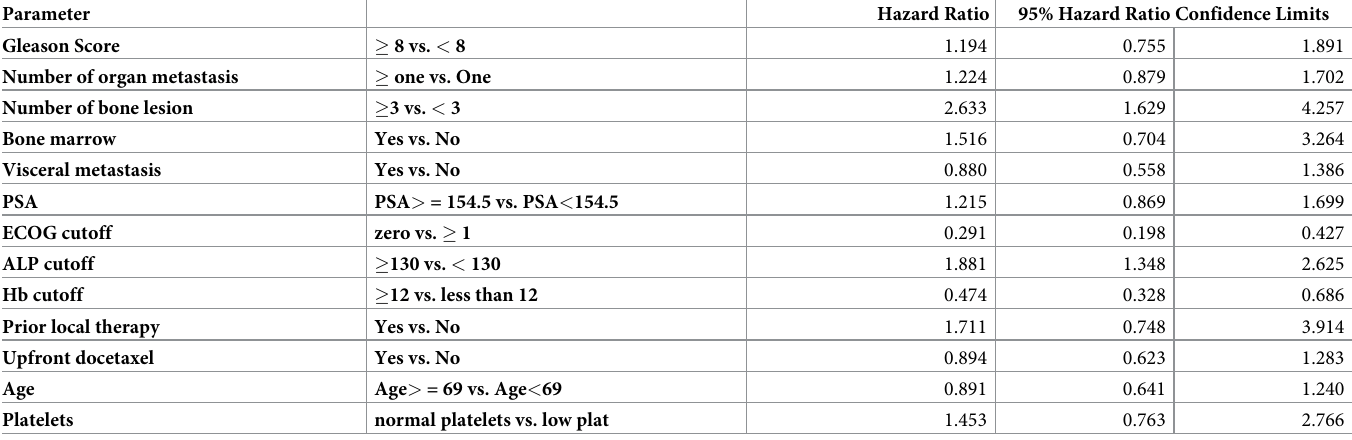
Table 2. Association between bone marrow involvement and PSA progression free survival on multivariate